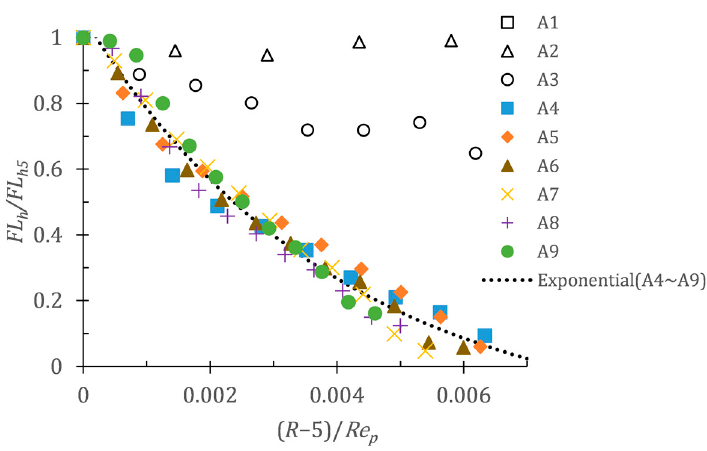
Figure 20. Dissipation of radial momentum flux of cases A1~A9.